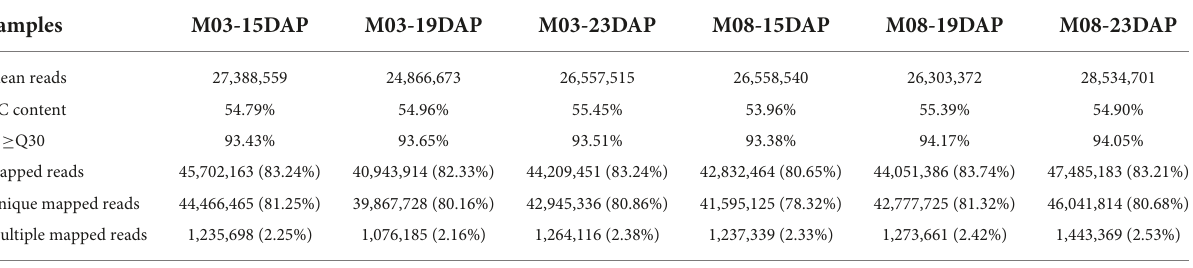
TABLE 1 Summary of mRNA sequencing datasets.